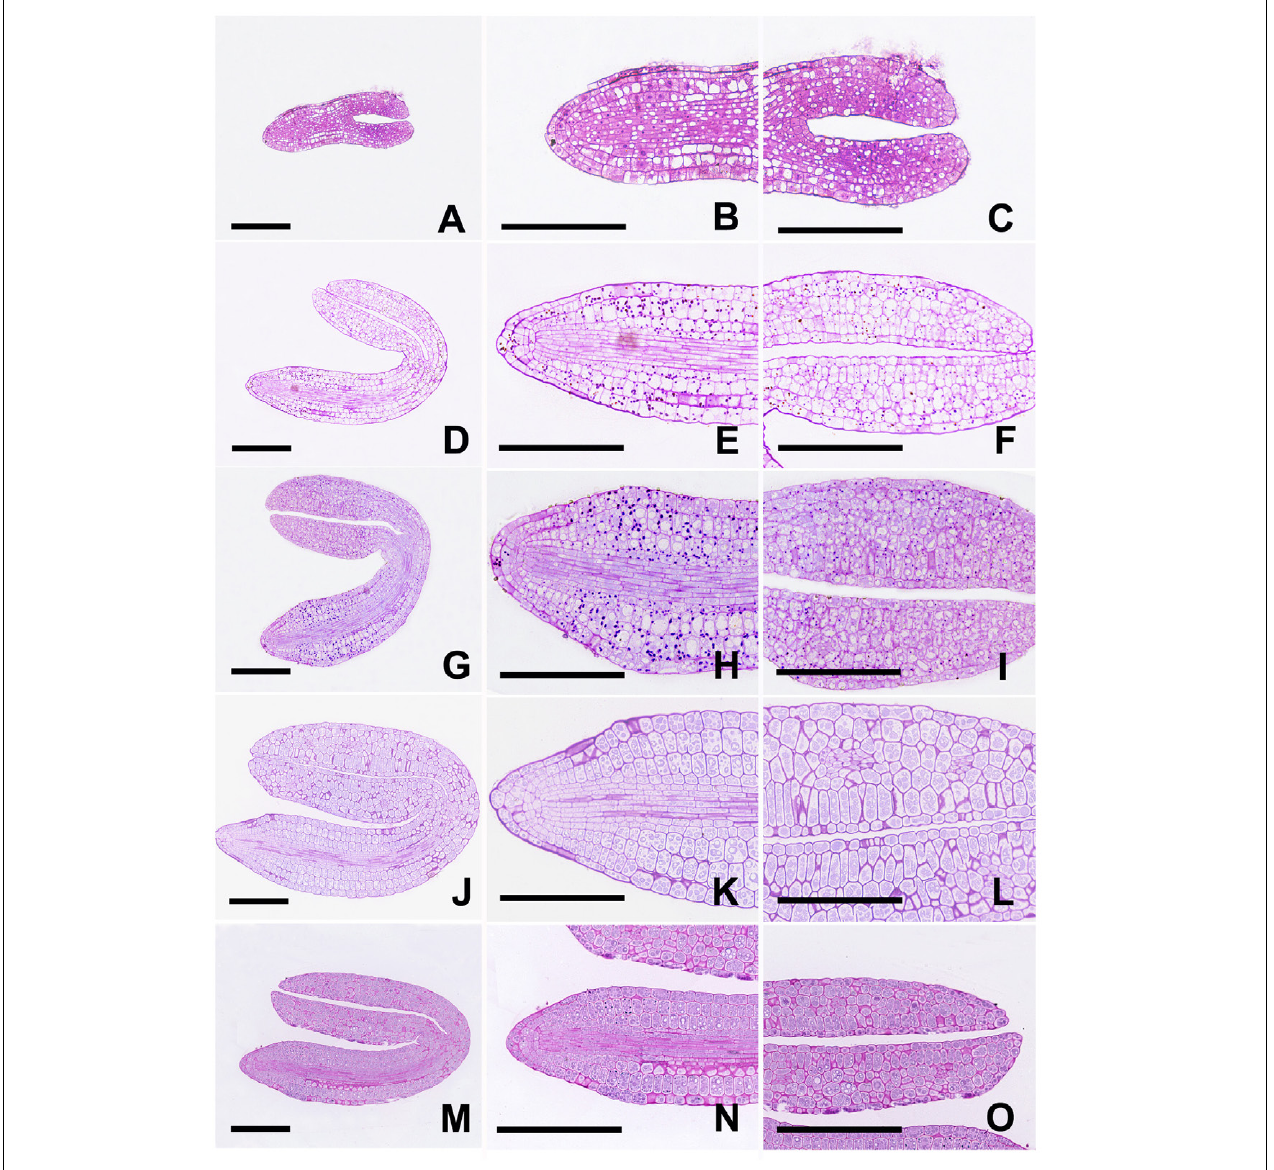
FIGURE 5 | Analysis of starch grains using periodic acid-Schiff reaction. Longitudinal sections of both control (A–L) and treated (M–O) embryos were prepared and stained with PAS reaction. (A–C) Embryos grown under control conditions for 6 DAP. (D–F) Embryos grown under control conditions for 8 DAP. (G–I) Embryos grown under control conditions for 10 DAP. (J–L) Embryos grown under control conditions for 12 DAP. (M–O) Embryos grown under light deprivation for 10 DAP. Figures B–C, E–F, H–I, K–L and N–O represent magnified views of Figures A, D, G, J and M , respectively. Bar = 100 µ